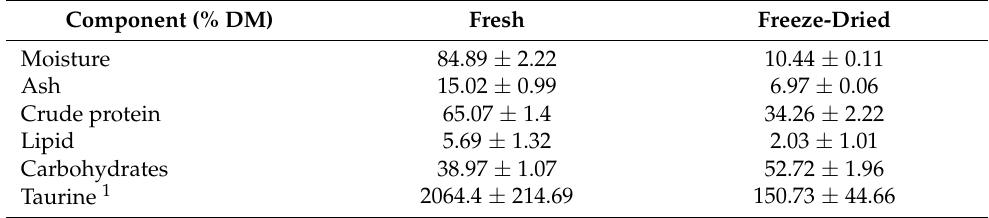
Table 2. Proximate composition and taurine content of fresh and dried soft tissue of S. woodiana . Component (% DM) Fresh Freeze-Dried Moisture 84.89 ± 2.22 Ash Crude protein Lipid